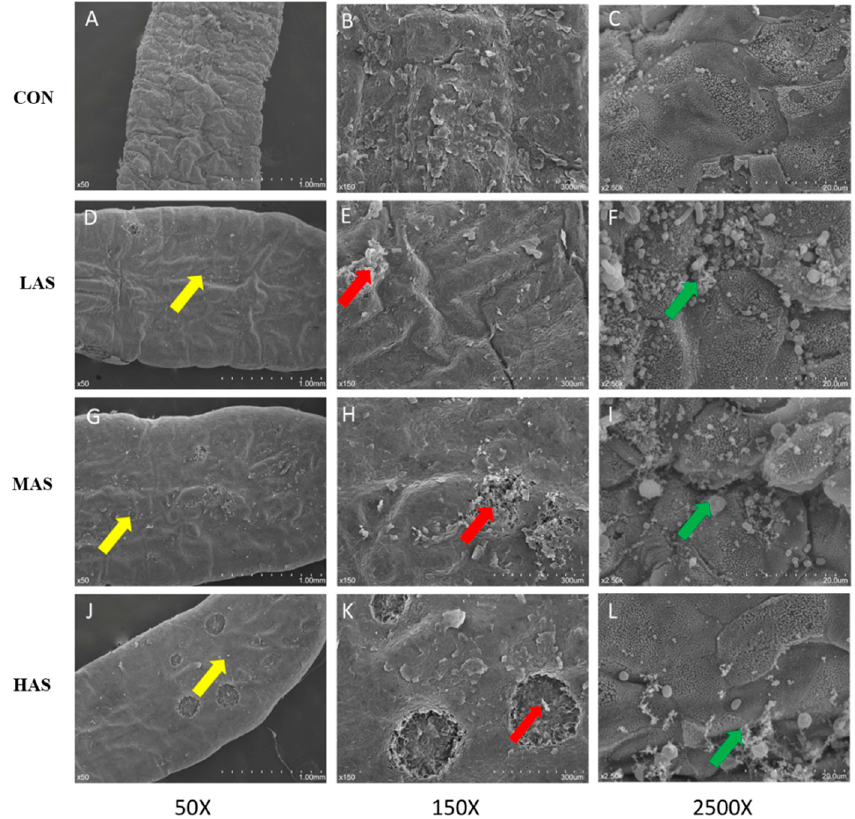
Figure 8. Scanning electron microscopy of papillae surface of different groups. CON-S (%DM) 0.4%; LAS-S (%DM) 0.6%; MAS-S (%DM) 0.8%; HAS-S (%DM) 1.0%. Cuticle exfoliation was more obviously ( A , D , G , J , shown as yellow arrows). Serious damage occurred on the surface of papillae ( B , E , H , K , shown as red arrows). More microbials were colonized ( C , F , I , L , shown as green arrows).